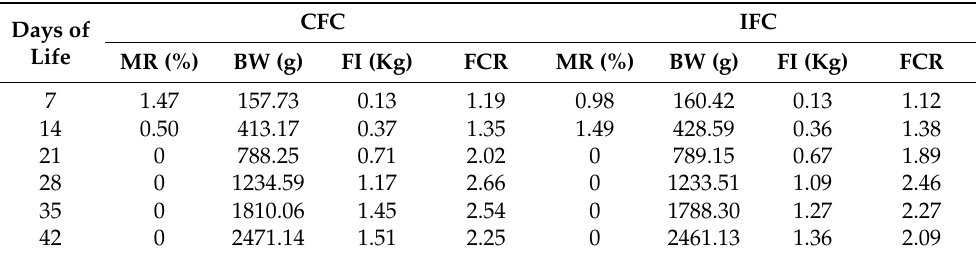
Table 2. Mortality rate (MR), body weight (BW), feed intake (FI) and feed conversion rate (FCR) of the animals for both experimental groups—commercial farm conditions (CFC) and improved farm conditions (IFC)—throughout the growing period.